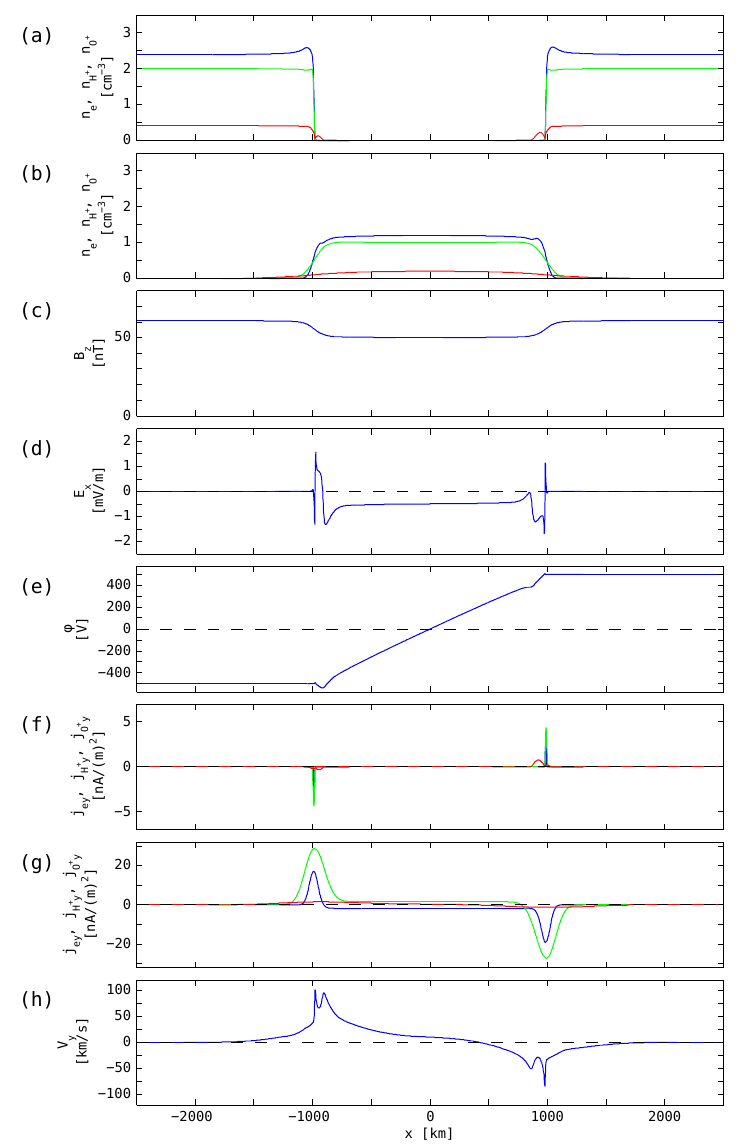
Fig. 8. Idem as Fig. 7 but now with φ( ±∞ ) = ±